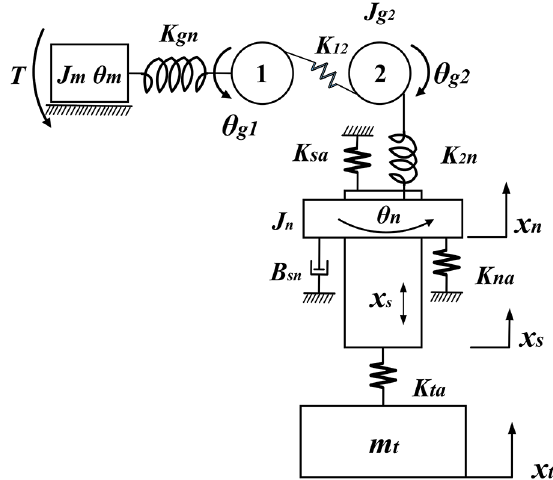
Fig. 3. Schematic for dynamic model of FDS based on